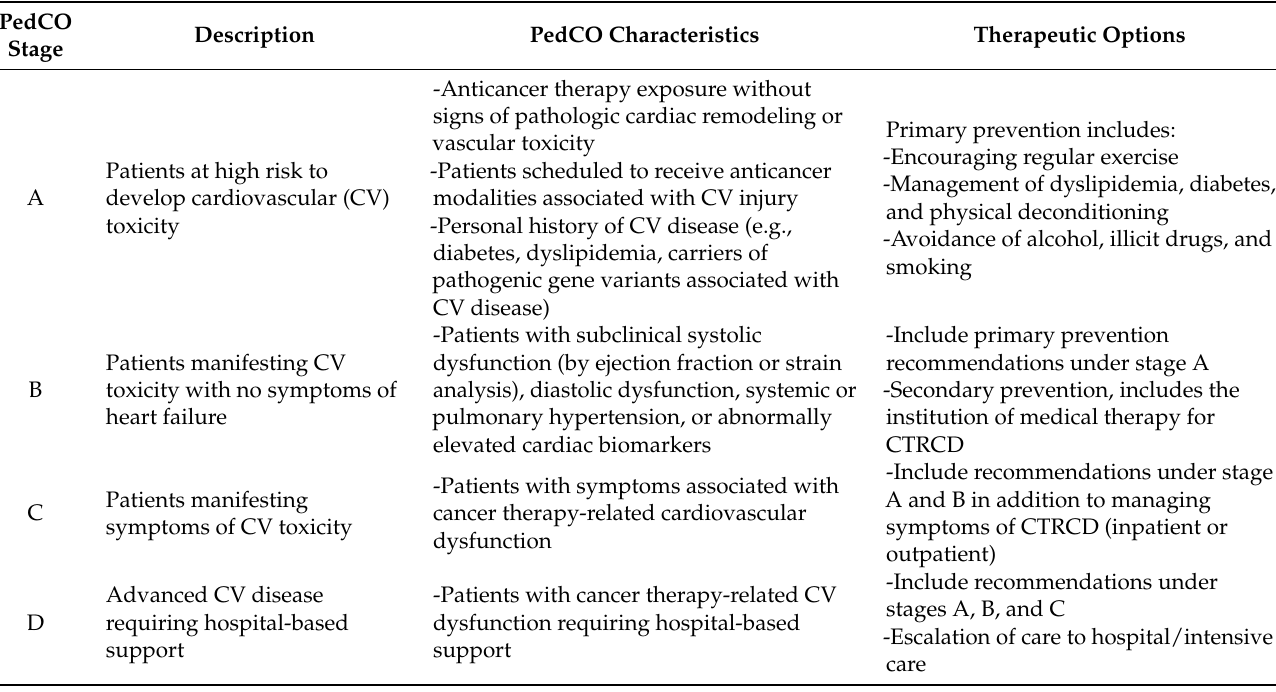
Table 3. Functional classification to diagnose and manage pediatric cardiology-oncology